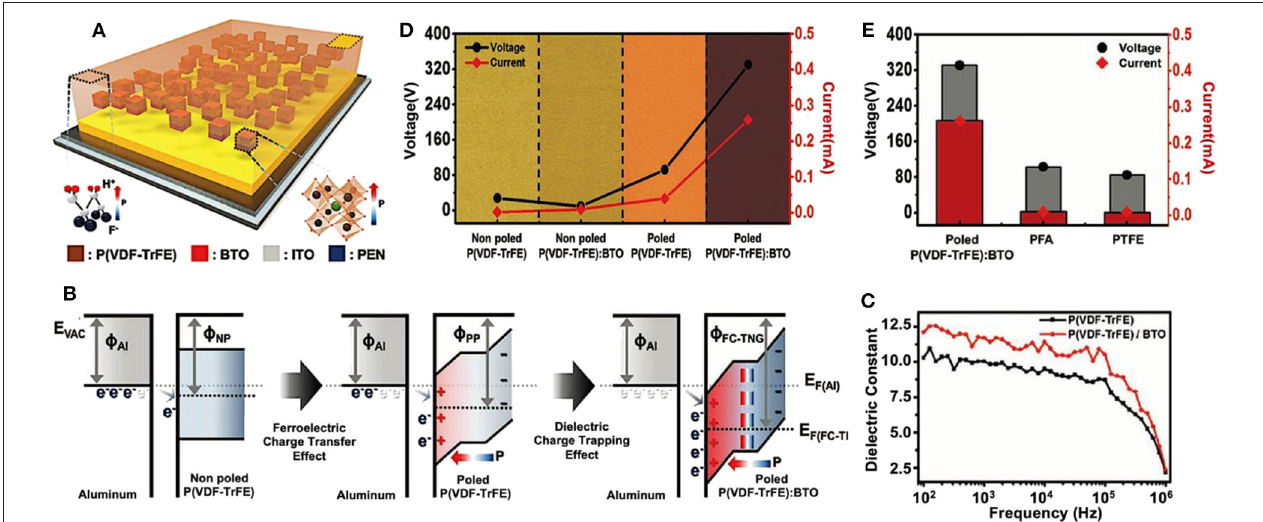
FIGURE 9 | Schematic diagrams and output performance of a ferroelectric composite-based TENG with dielectric nanoparticles BTO. (A) Schematic representations of the structure of as-modified TENG. (B) The charge transfer behavior between two different material surfaces and its corresponding energy band modification. (C) The dielectric constant of P(VDF-TrFE) with and without dielectric nanoparticles BTO. (D) The output voltage and current of TENGs with different modification depending on with or without two effects: ferroelectric and dielectric. (E) Output performance comparison between ferroelectric composite-based TENG with BTO nanoparticles and TENGs with traditional polymer films. Reprinted with permission from Seung et al. (2017). Copyright 2017 John Wiley & Sons.